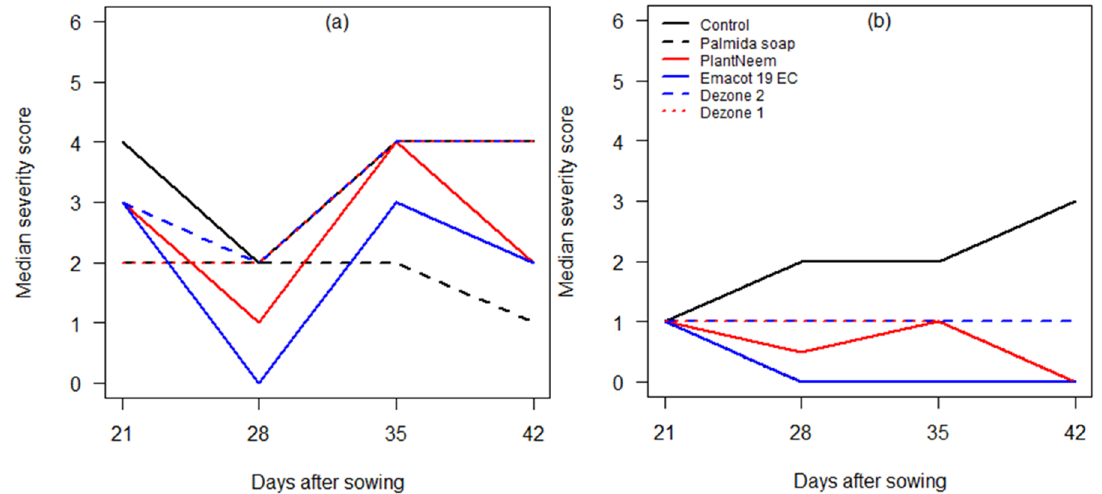
Figure 4. Effects of insecticide application on S. frugiperda larvae damage severity based on weekly observations of 15 maize plants per plot at Adjohoun ( a ) and 30 plants at N’Dali ( b ) on each collection date. Insect damage severity scores were adapted from Reference [34] and described in the Methods section. Dezone 1 and 2 refer to application rates of 7.5 and 15 kg/ha, respectively.